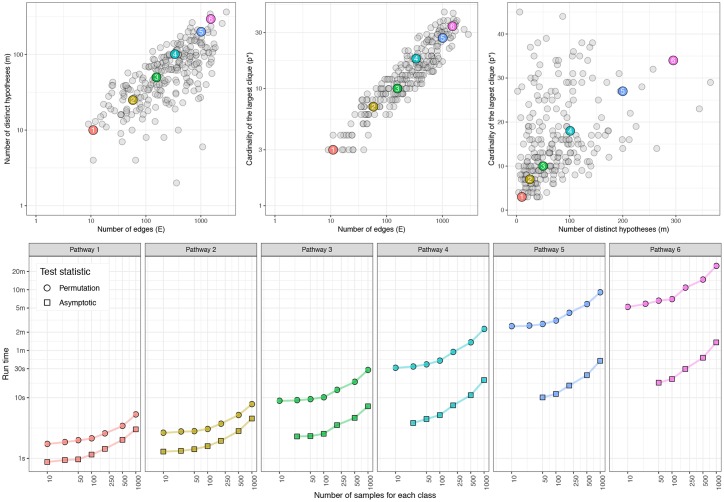
SourceSet run-time analysis.(Top panel) All pairwise relationships between the parameters that define the complexity of a graph (i.e., the number of edges, the number of distinct hypotheses and the cardinality of the largest clique) for 248 KEGG pathways. Six pathways—highlighted with filled circles of different colors—of increasing complexity were chosen for the run-time analysis (see also Table 4). (Bottom panel) Run-time for the six pathways as a function of the sample size. Permutation tests and asymptotic tests are plotted with circles and squares, respectively.